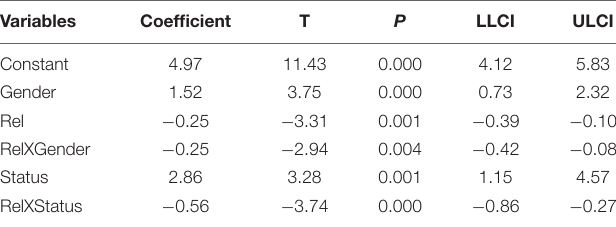
TABLE 3 | Moderation model using status and gender between relationship with the outgroup and organizational dehumanization.